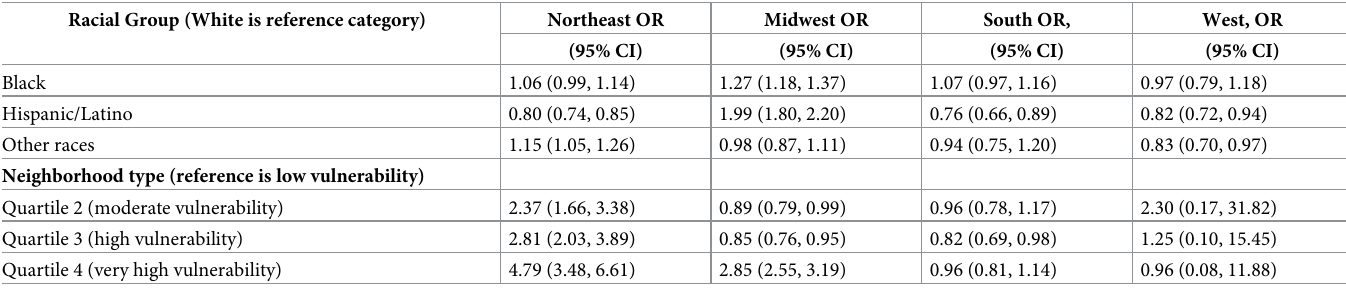
Table 5. Comparing disparities in mortality among hospitalized COVID-19 patients across the 4 census regions. Racial Group (White is reference category) Northeast